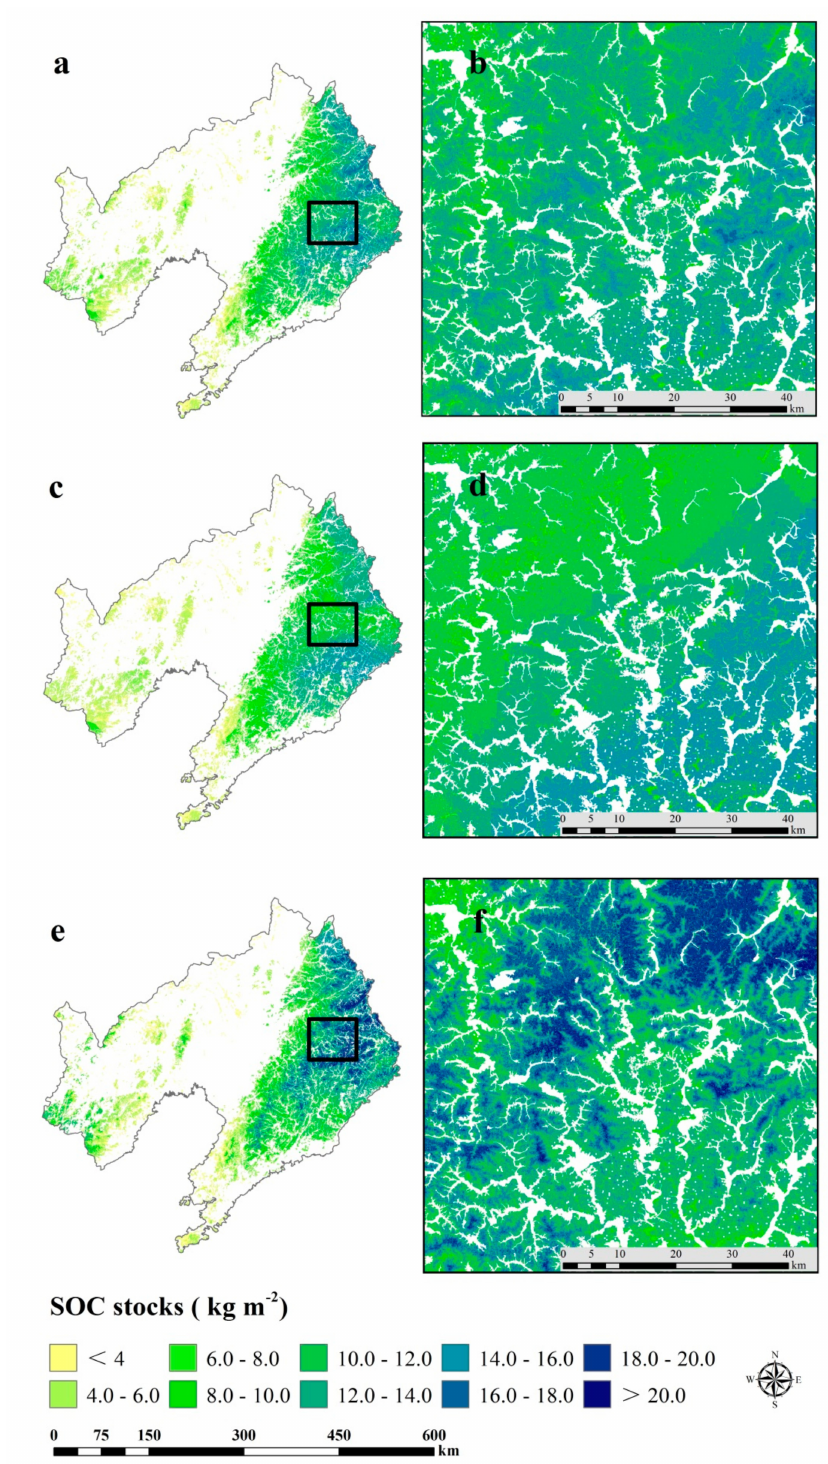
Figure 7. Spatial distribution of the predicted topsoil (0–30 cm) soil organic carbon (SOC) stocks with models of geographically weighted regression (GWR) ( a , b ), multiple stepwise linear regression (MSLR) ( c , d ), and boosted regression trees (BRT) ( e , f